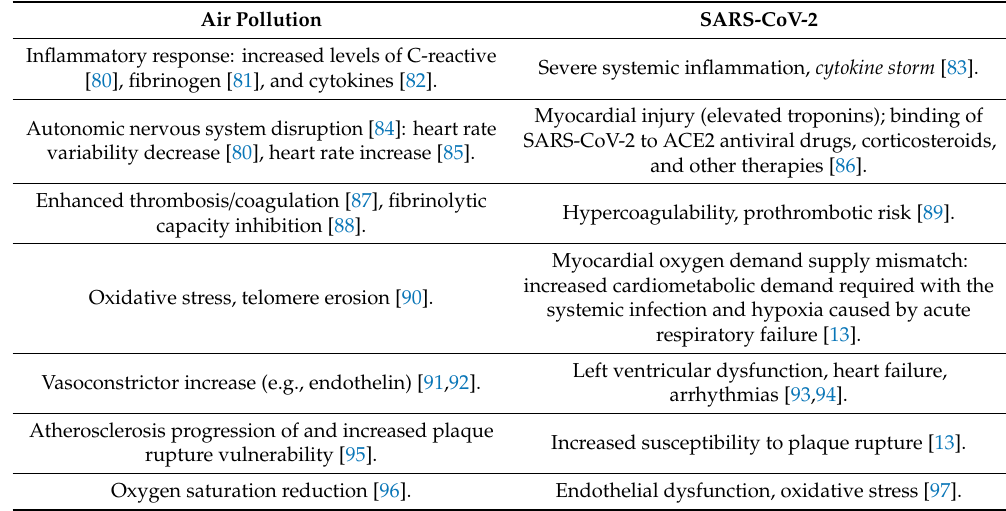
Table 1. Possible mechanisms by which air pollutants and SARS-CoV-2 may trigger myocardial damage and acute myocardial